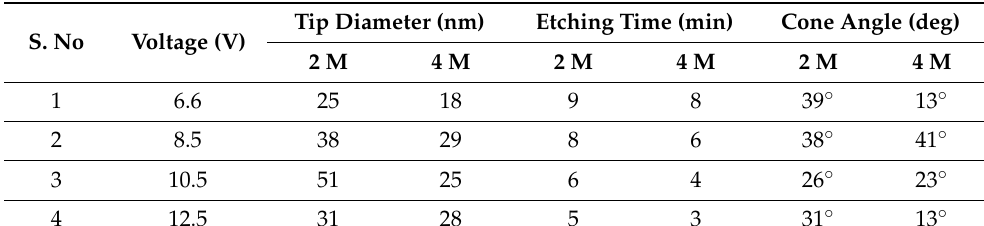
Table 5. Experimental results for 0.4 mm tips showing tip diameter, Etching time and Cone Angle produced in 2 M NaOH solution on DC